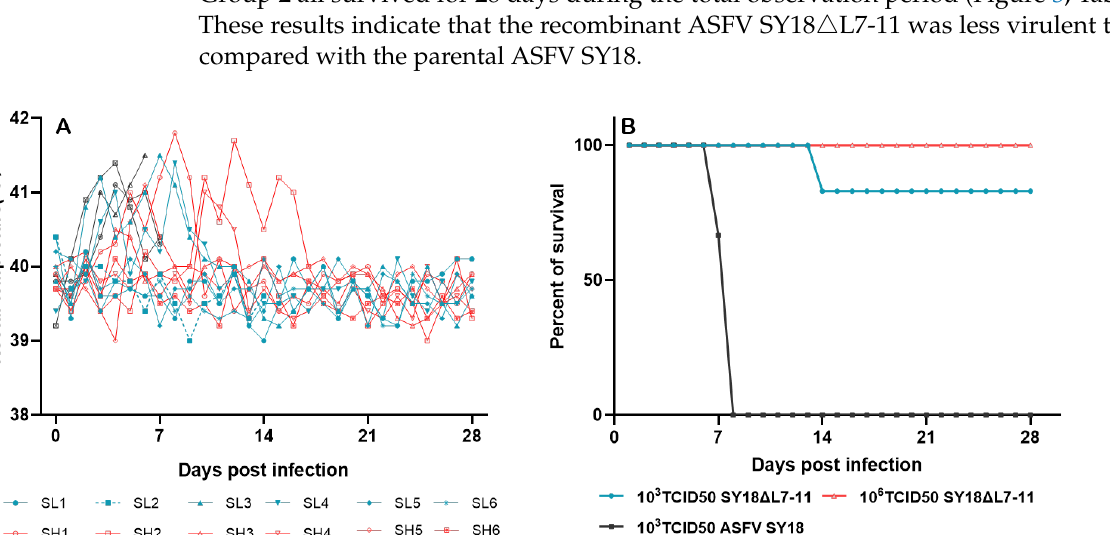
Figure 2. In vitro growth characteristics of SY18 △ L7-11 and parental ASFV SY18. Primary swine rental ASFV SY18. Samples were taken from three independent experiments at the indicated times